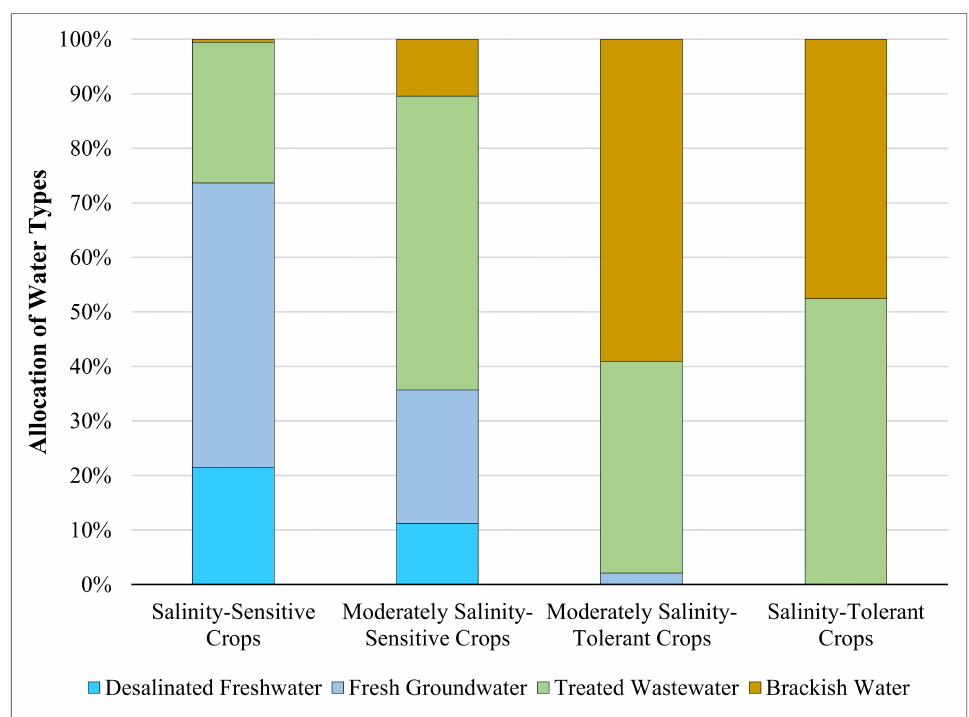
Figure 2. Optimal allocation of the four irrigation water types that differ in terms of their salinity levels to four groups of crops with different salinity